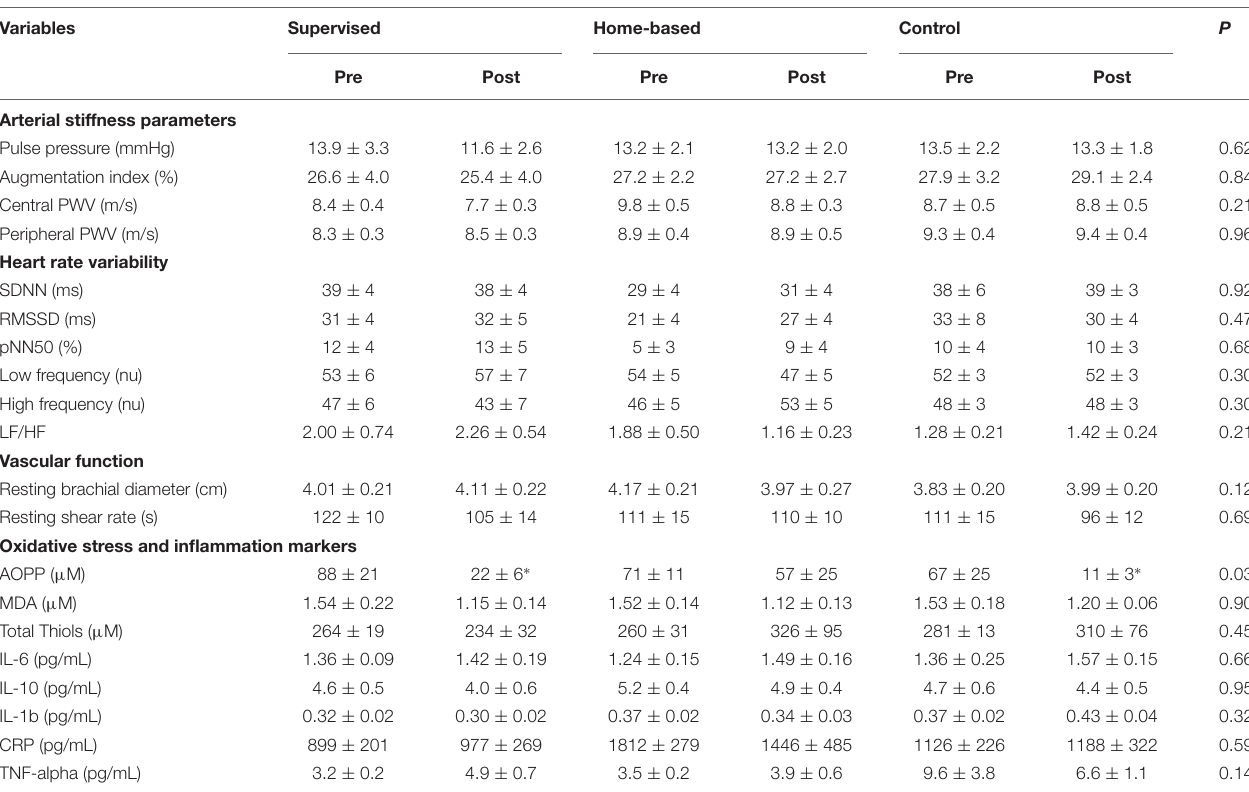
TABLE 3 | Effects of home-based and supervised isometric handgrip training and control on cardiovascular parameters in hypertensives. Variables Supervised